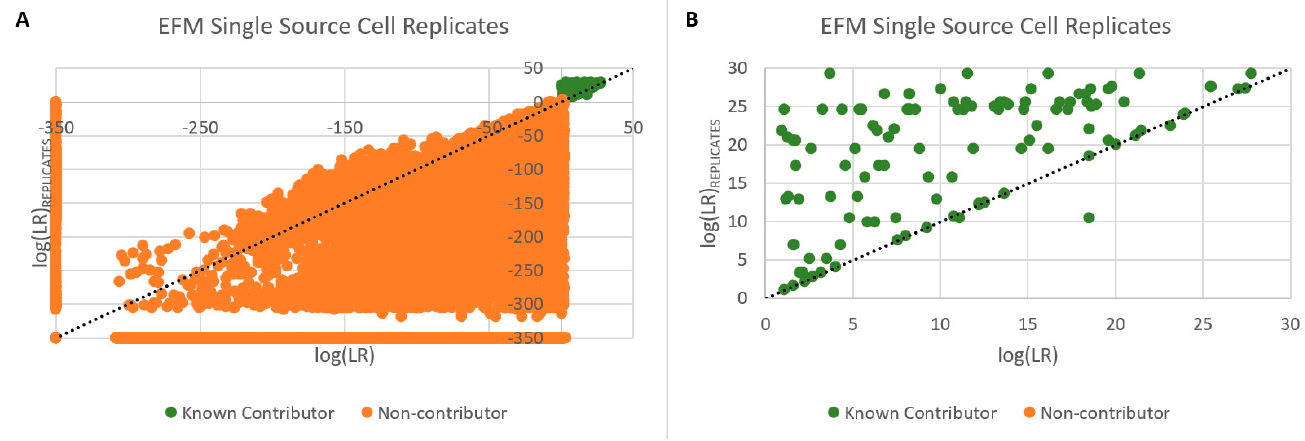
Figure 14. Specificity improvement of DSCS (EFM) with replicate analysis. Known contributors above the diagonal (i.e., y = x) represent improved LR recovery from replicate analysis. Single Source Cell Replicates. LR = 0 plotted as − 350. Green circles (known contributors); orange circles (non-contributors). ( A ) All samples. ( B ) Detail showing log(LR) > 0 samples.